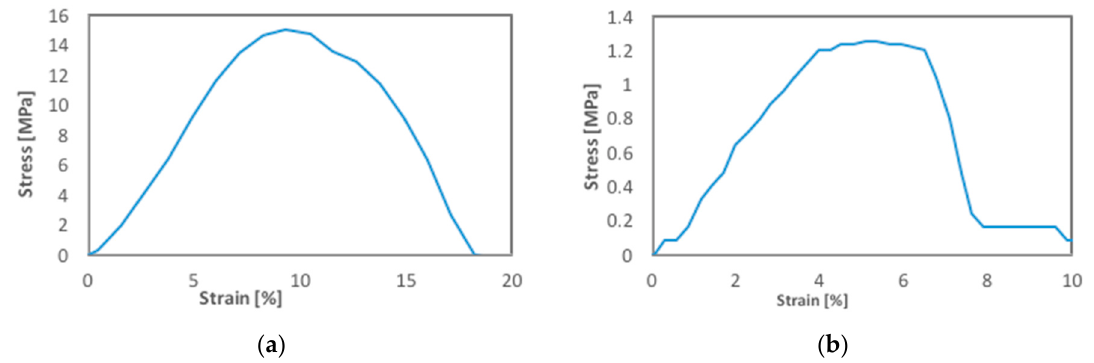
Figure 7. Axial compressive stress-strain curves for RS pellets ( a ) and RH pellets ( b ) .